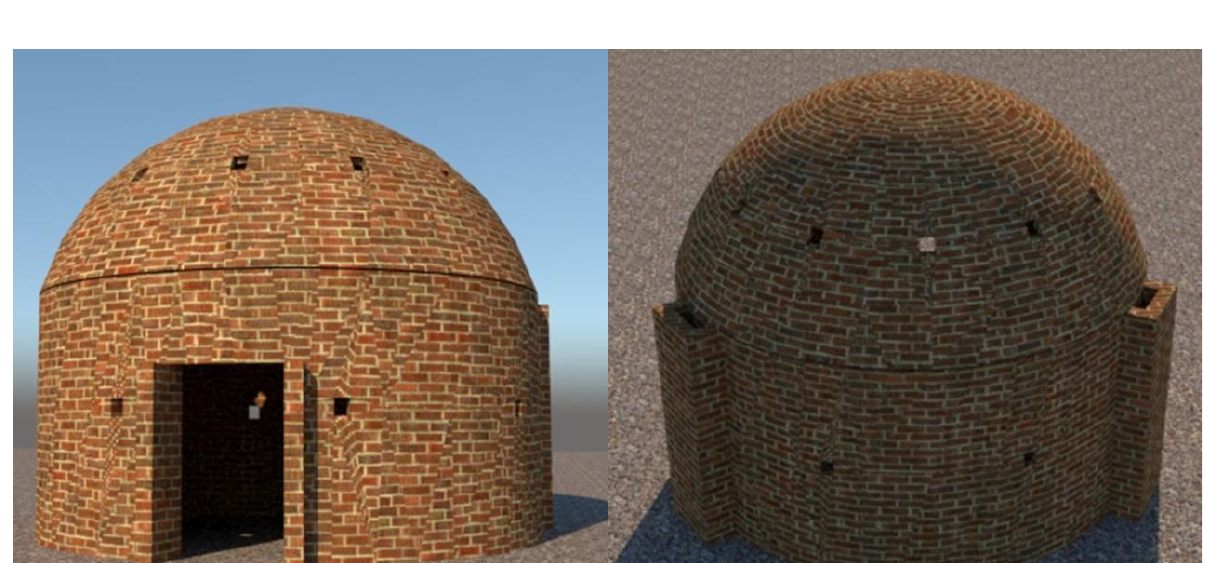
Figure 2. Design of a Brazilian beehive type kiln.